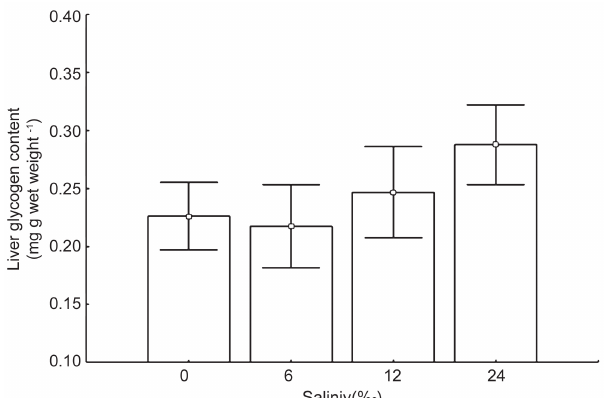
Fig. 3. Liver glycogen content in juvenile Lebranche mullet Mugil liza (n = 6) after acclimation to different salinities for 40 days. Data are expressed as mean ± standard